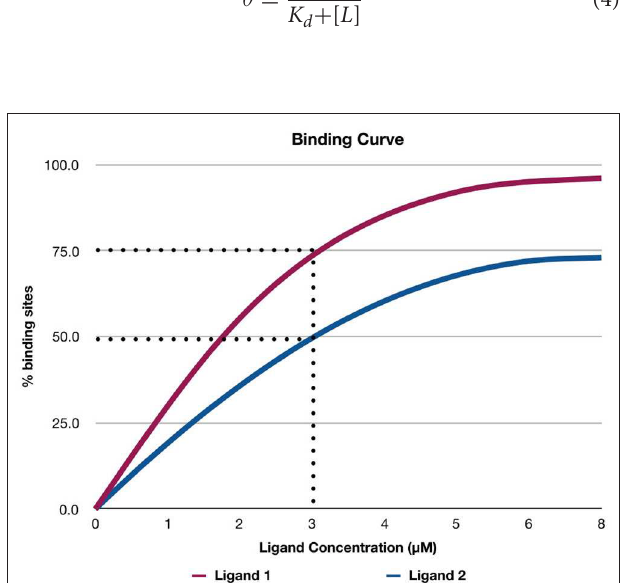
FIGURE 2 | A hypothetical example of a binding curve for ligand 1 and ligand 2. The x -axis shows the concentration of the ligand, and the y -axis shows the percentage of available binding sites ( 2 ) in a protein that is occupied by the ligand.